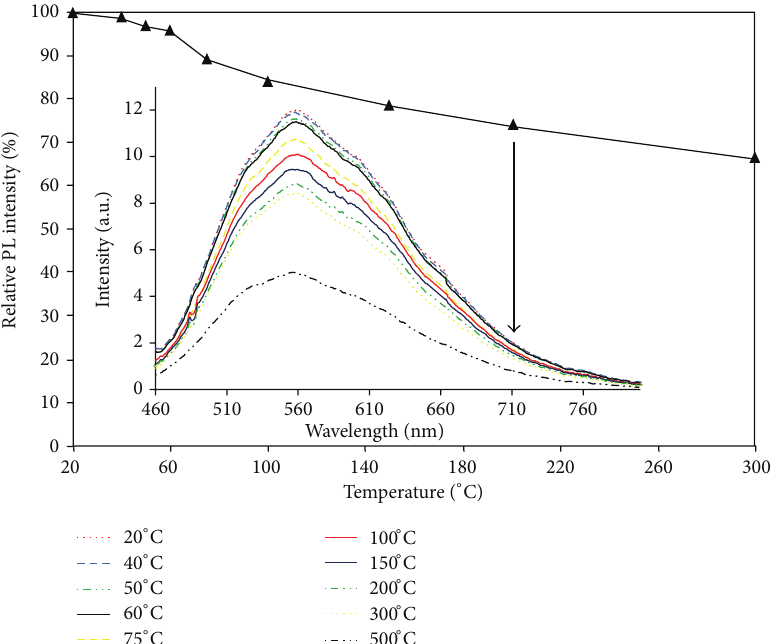
Figure 9: Temperature dependent relative PL emission intensity of Zn 3 V 2 O 8 phosphor. Inset shows the emission spectra of Zn 3 V 2 O 8 phosphor as a function of temperature.